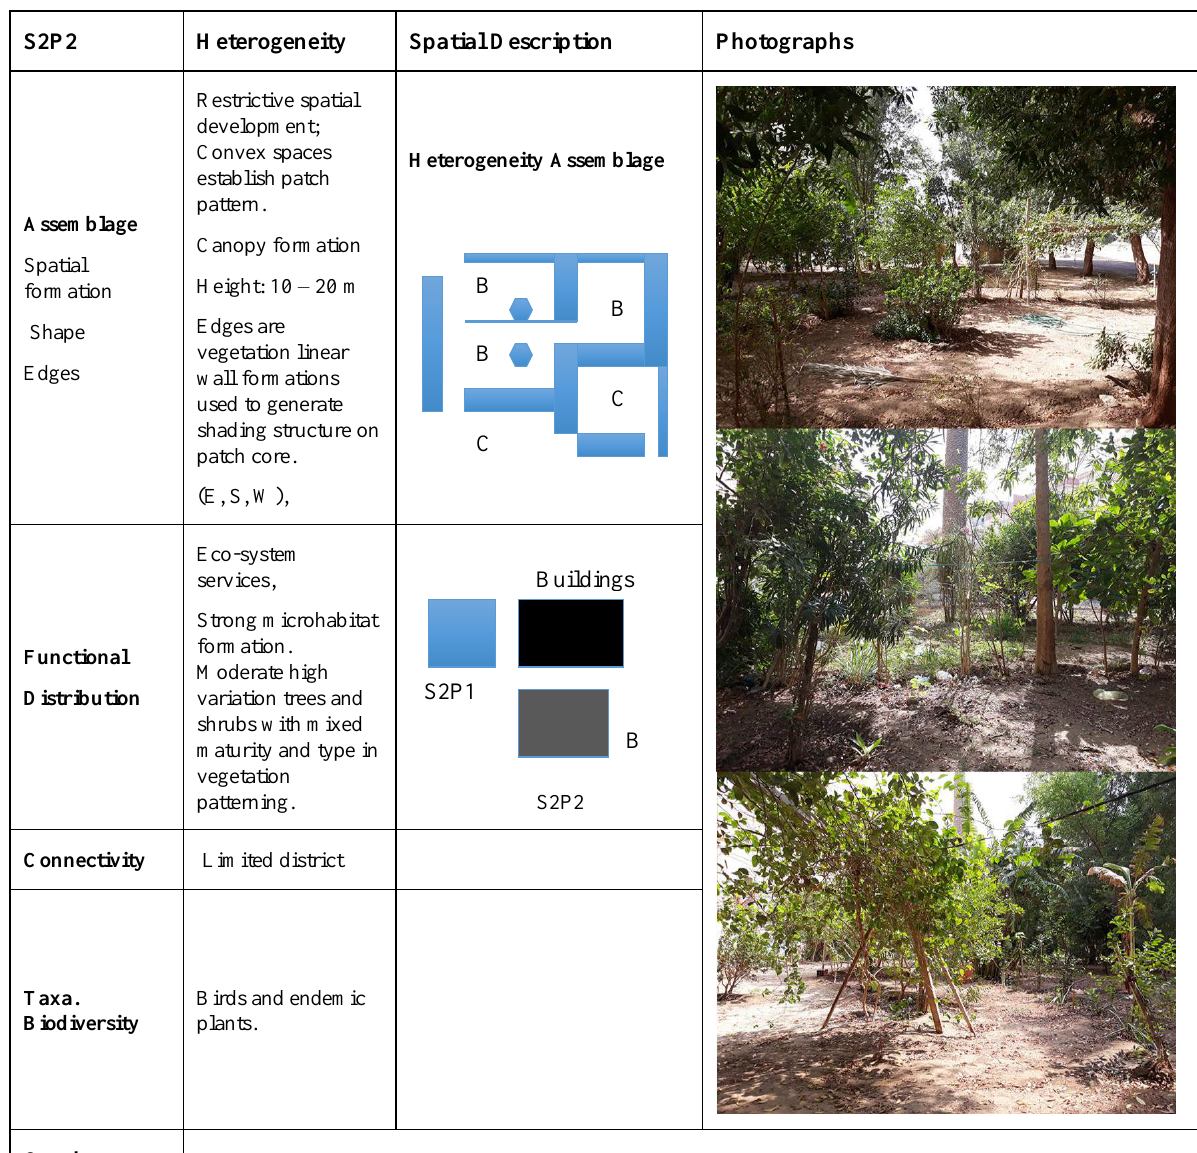
Table 6. Site 2 Patch2 description of habitat